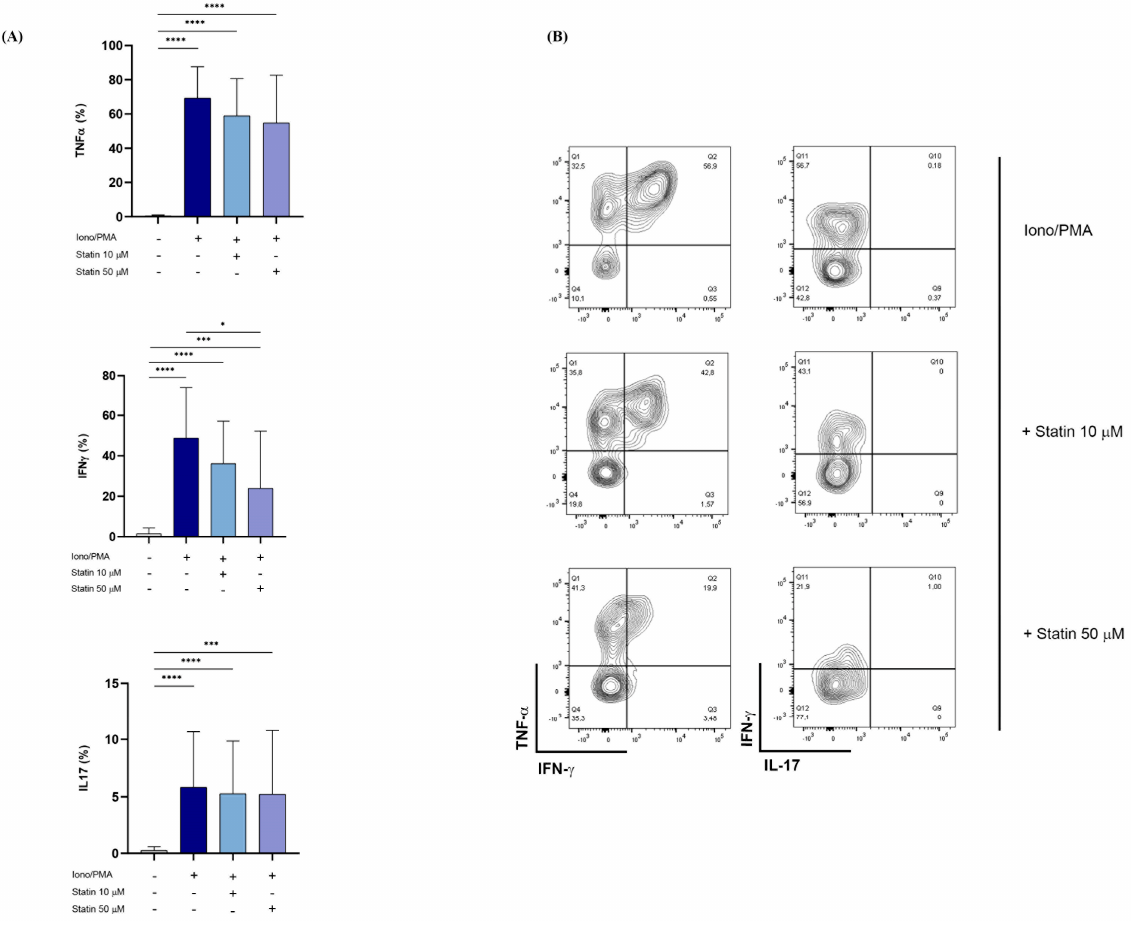
Figure 8. Inhibition of V δ 2+ T cell cytokine expression by atorvastatin upon Iono/PMA stimulation. ( A ) Intracellular levels of TNF- α , IFN- γ , and IL-17 expressed by V δ 2+ T cells from COVID-19 patients upon stimulation with Iono/PMA in presence of atorvastatin. Data are represented as histogram plots, showing mean ± SD. Blue histogram represented Iono/PMA condition, light blue histogram represented Iono/PMA + 10 µ M statin condition, and light blue powder histogram represented Iono/PMA + 50 mM statin condition. ( B ) Representative counterplots showing pro-inflammatory cytokine expression by V δ 2+ T lymphocytes. * p < 0.05, *** p < 0.001, and **** p < 0.0001.